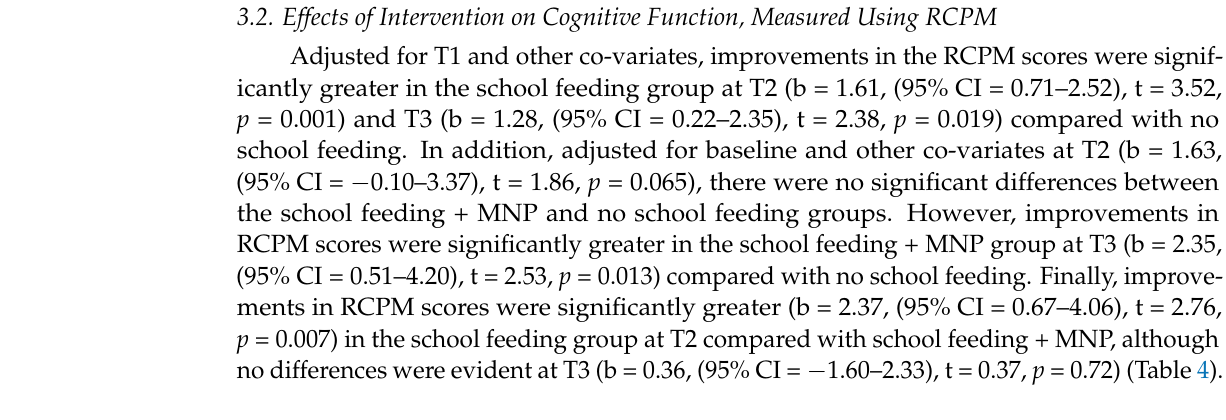
Table 4. Means and standard deviations for the Ravens’ Coloured Progressive Matrices (RCPM)